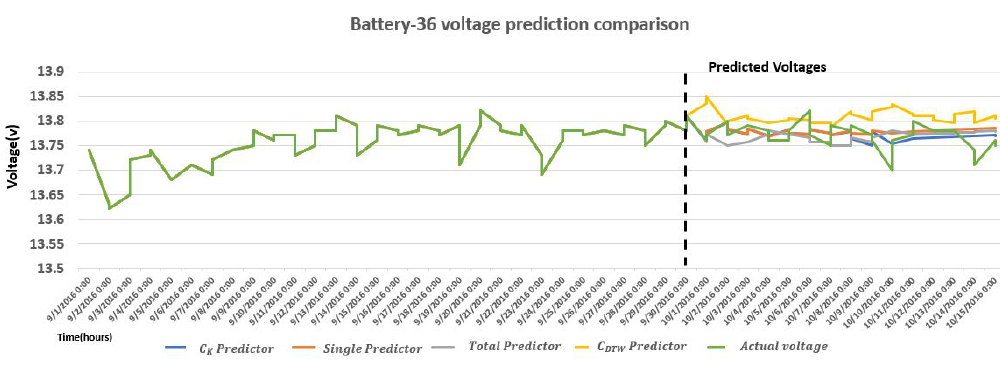
Figure 14. Comparison of measured and ARIMA forecasted voltage with C K , Single, Total, and C DTW predictor of Battery